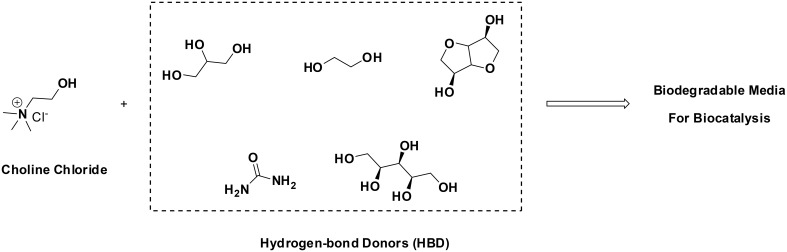
Formation of biodegradable DES as promising environmentally-friendly solvents for biocatalysis (Domínguez de María, 2012; Maugeri et al., 2013; Maugeri and Domínguez de María, 2014a,b; Müller et al., 2015).